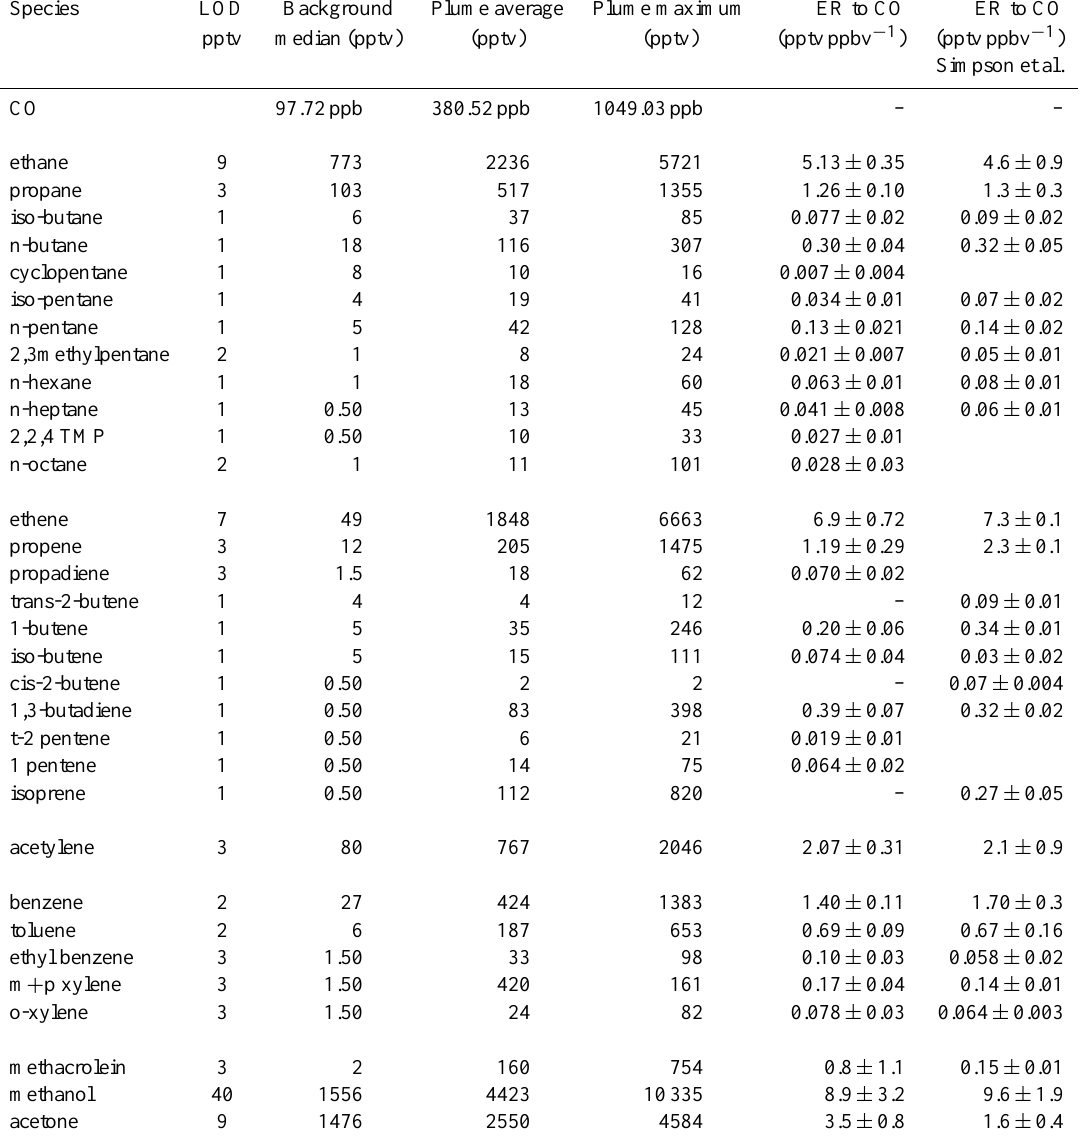
Table 1. Measurement statistics from the observations made during the BORTAS campaign. Any values observed below the limit of detection (LOD) have been assigned a value of half the LOD to enable a background value to be calculated. Median averages have been reported for the background mixing ratios in order to reduce the effect of a small number of samples with higher than expected VOC mixing ratios (likely corresponding to localised emissions from an unknown source) which would otherwise yield unrepresentatively high background